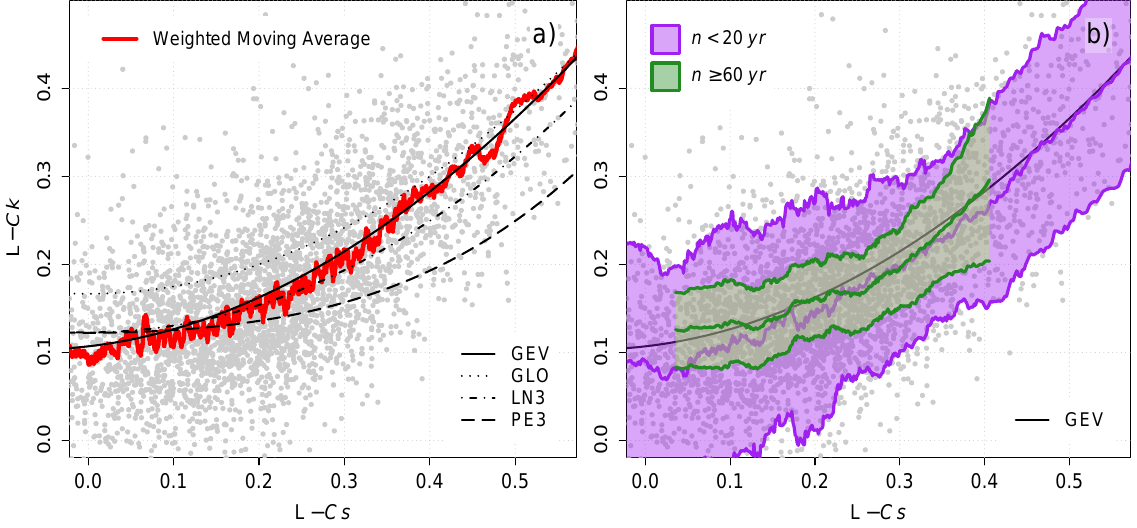
Figure 1. L-Cs–L-Ck diagram for the FloodFreq database with (a) the record length weighted moving average over 50 catchments (red line) for the whole database and (b) the record length weighted moving averages and standard deviations for stations with more than 60yr (green lines and polygon) and less than 20yr of data (purple lines and polygon) separately.